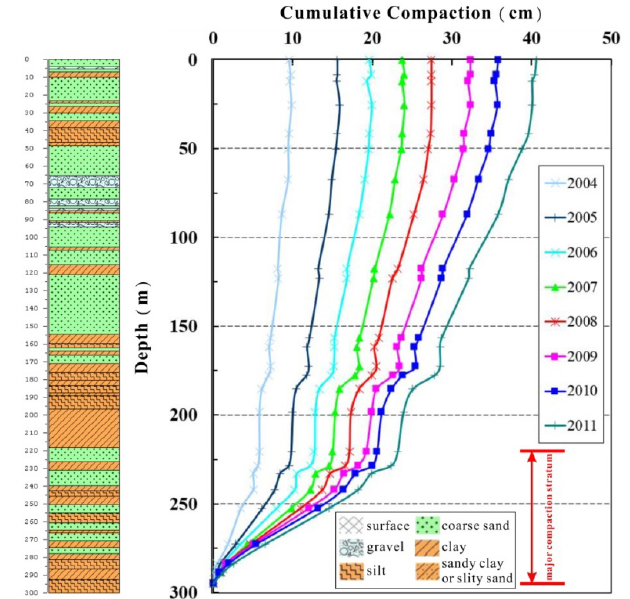
Figure 8. Layers of sediments and cumulative compactions from 2004 to 2011 at TKJS.